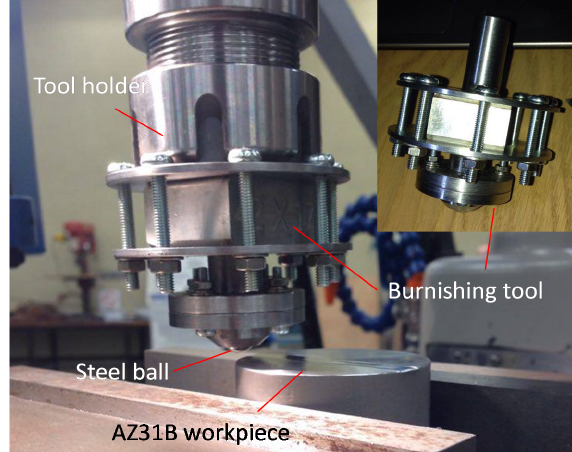
Figure 2. Experimental setup of the burnishing.